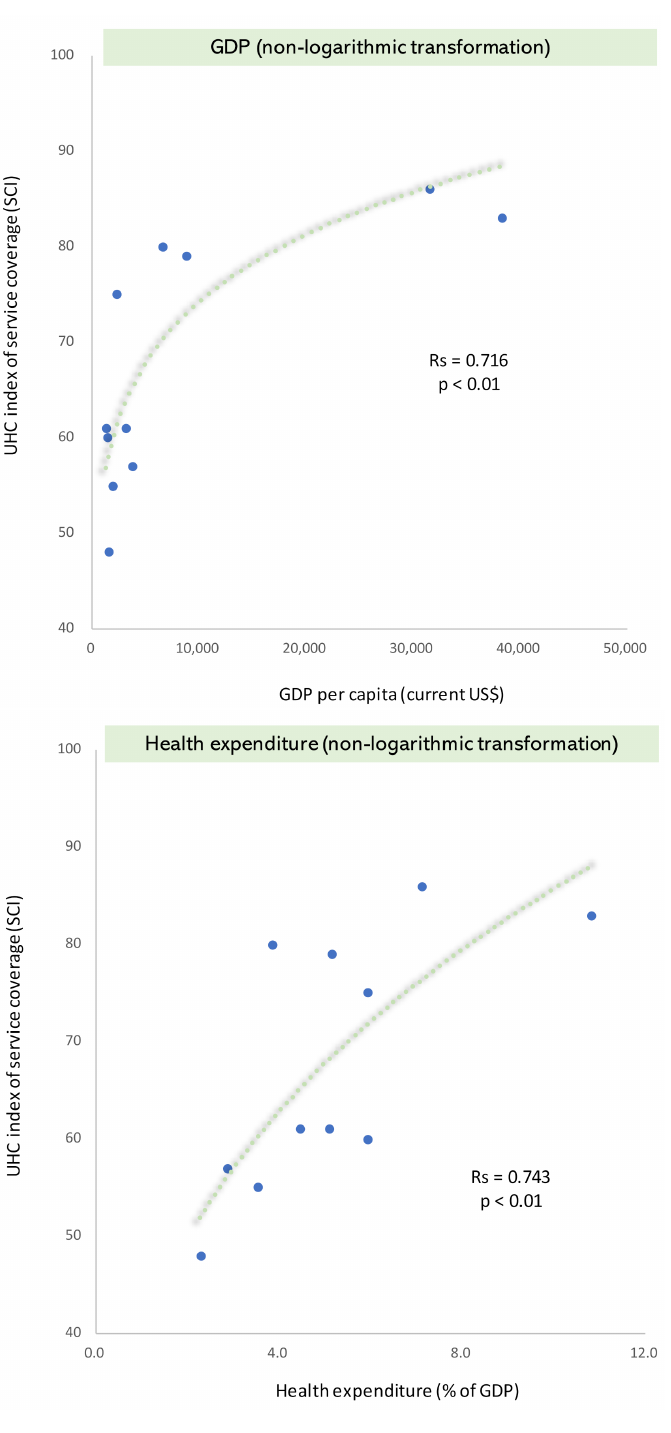
Figure 1. Interrelationship between economic levels (GDP and health expenditure) and SCI levels. Note: UHC, universal health coverage; SCI, service coverage